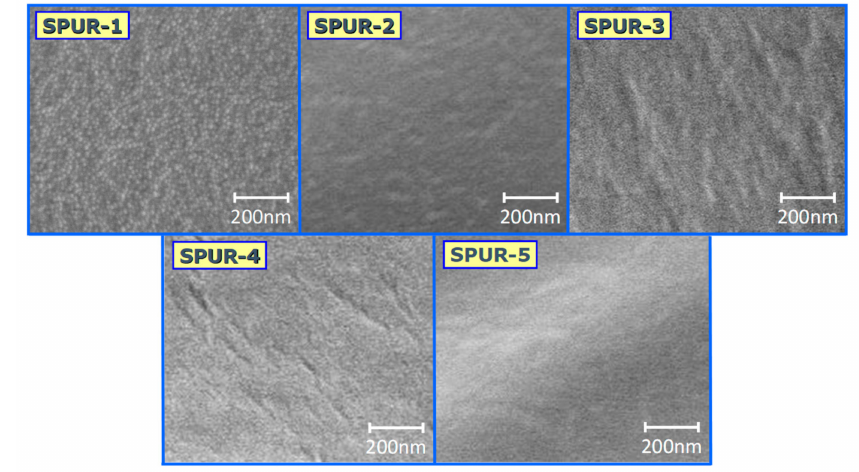
Figure 6. SEM images of SPUR samples.